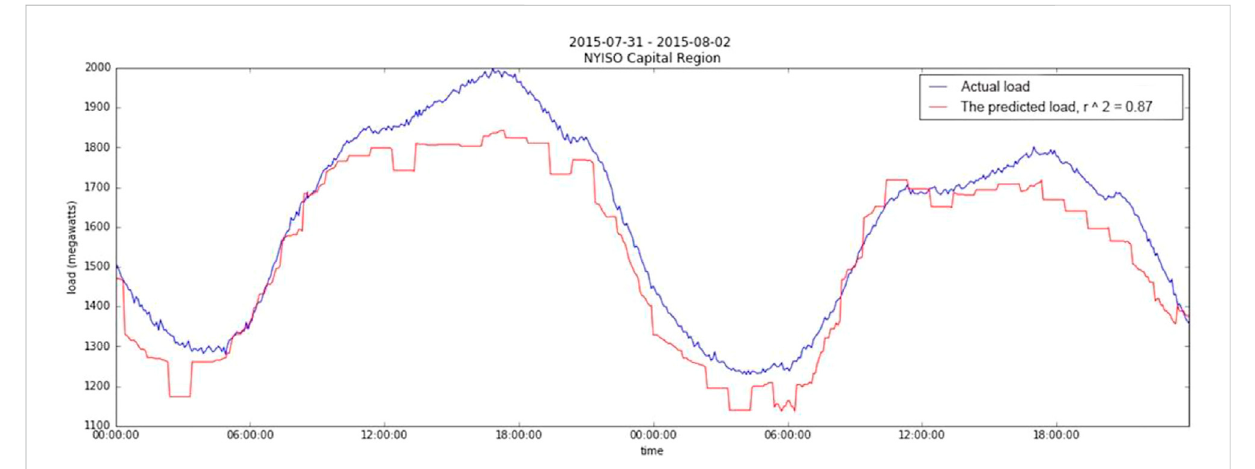
FIGURE 6 The forecasted EEC from the end of July 2015 to the beginning of August